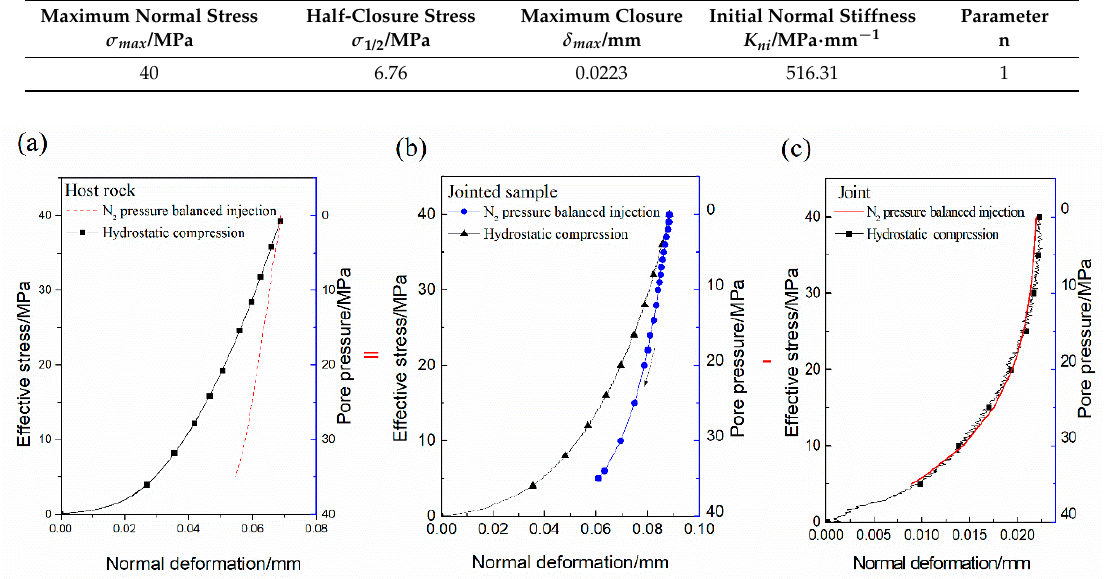
Figure 11. Decomposition of normal deformation of jointed sample induced by pore N 2 pressure: ( a ) component of host rock; ( b ) total normal deformation of jointed sample; and ( c ) component of the joint.